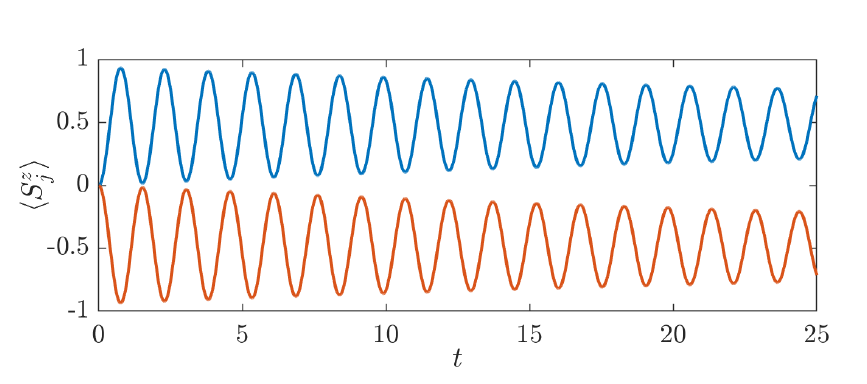
= 0.5, ω = 1.5 and ε = 2 when A B 〈 0 | ⊗ | 0 〉 〈 0 | . This is a consequence of the A A B B